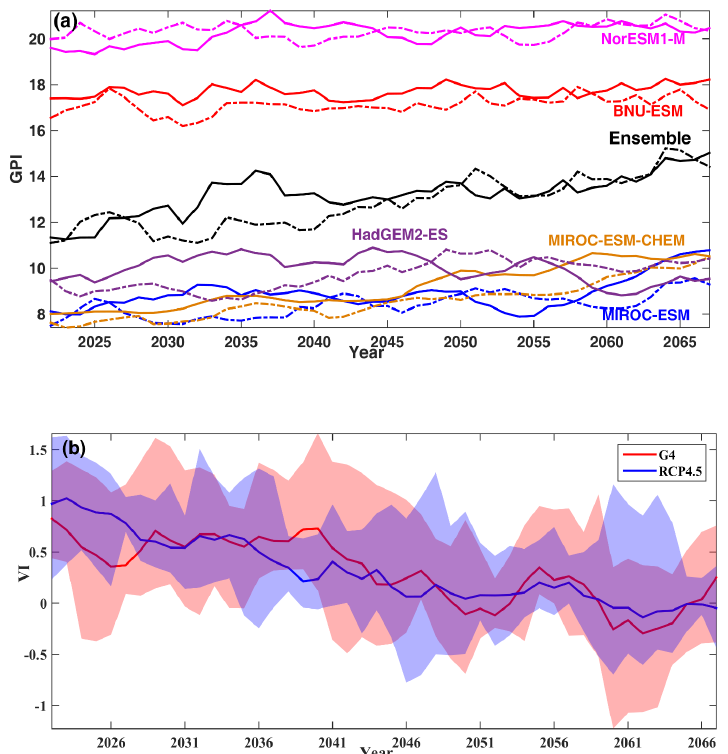
Figure 1. Five yearly moving annual averages across the six TC basins and TC season of (a) normalized GPI shifted by the each model’s mean over 2020–2069; solid lines denote forcing under RCP4.5 and dotted lines values under G4. The ensemble was calculated as the mean of normalized models then offset by the mean across-model GPI. (b) VI with solid lines denoting model ensemble means and shading indicating the range across the five models.